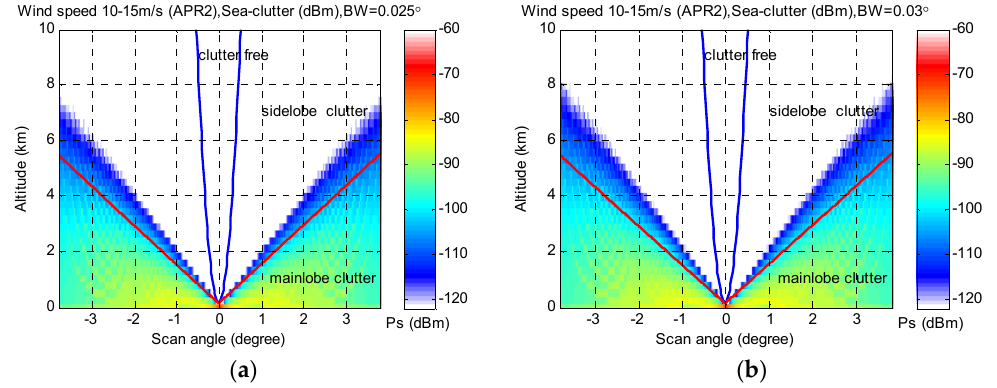
Figure 9. Power distribution (dBm) of sea clutter under different beamwidths where wind speed is 10–15 m/s. The data of NRCS is measured by APR2. ( a ) Beamwidth (BW): 0.025°; and ( b ) beamwidth (BW): 0.03°; Figure 4c ahead has shown the similar calculation with a beamwidth (BW): 0.02°.